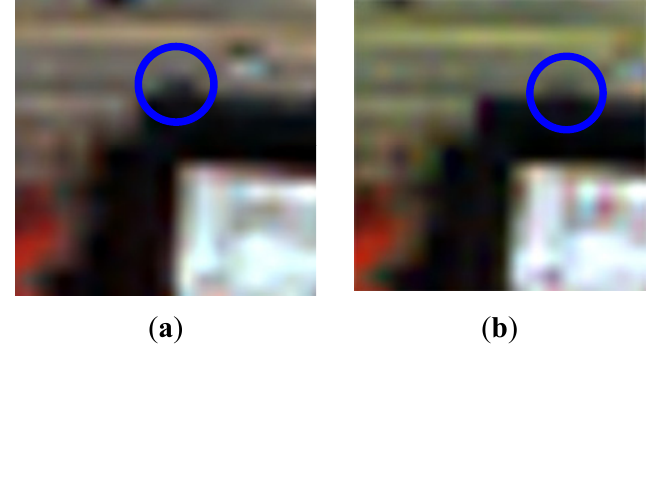
Figure 18. A vehicle passing under building shadows: ( a ) MS1 image; ( b ) MS2